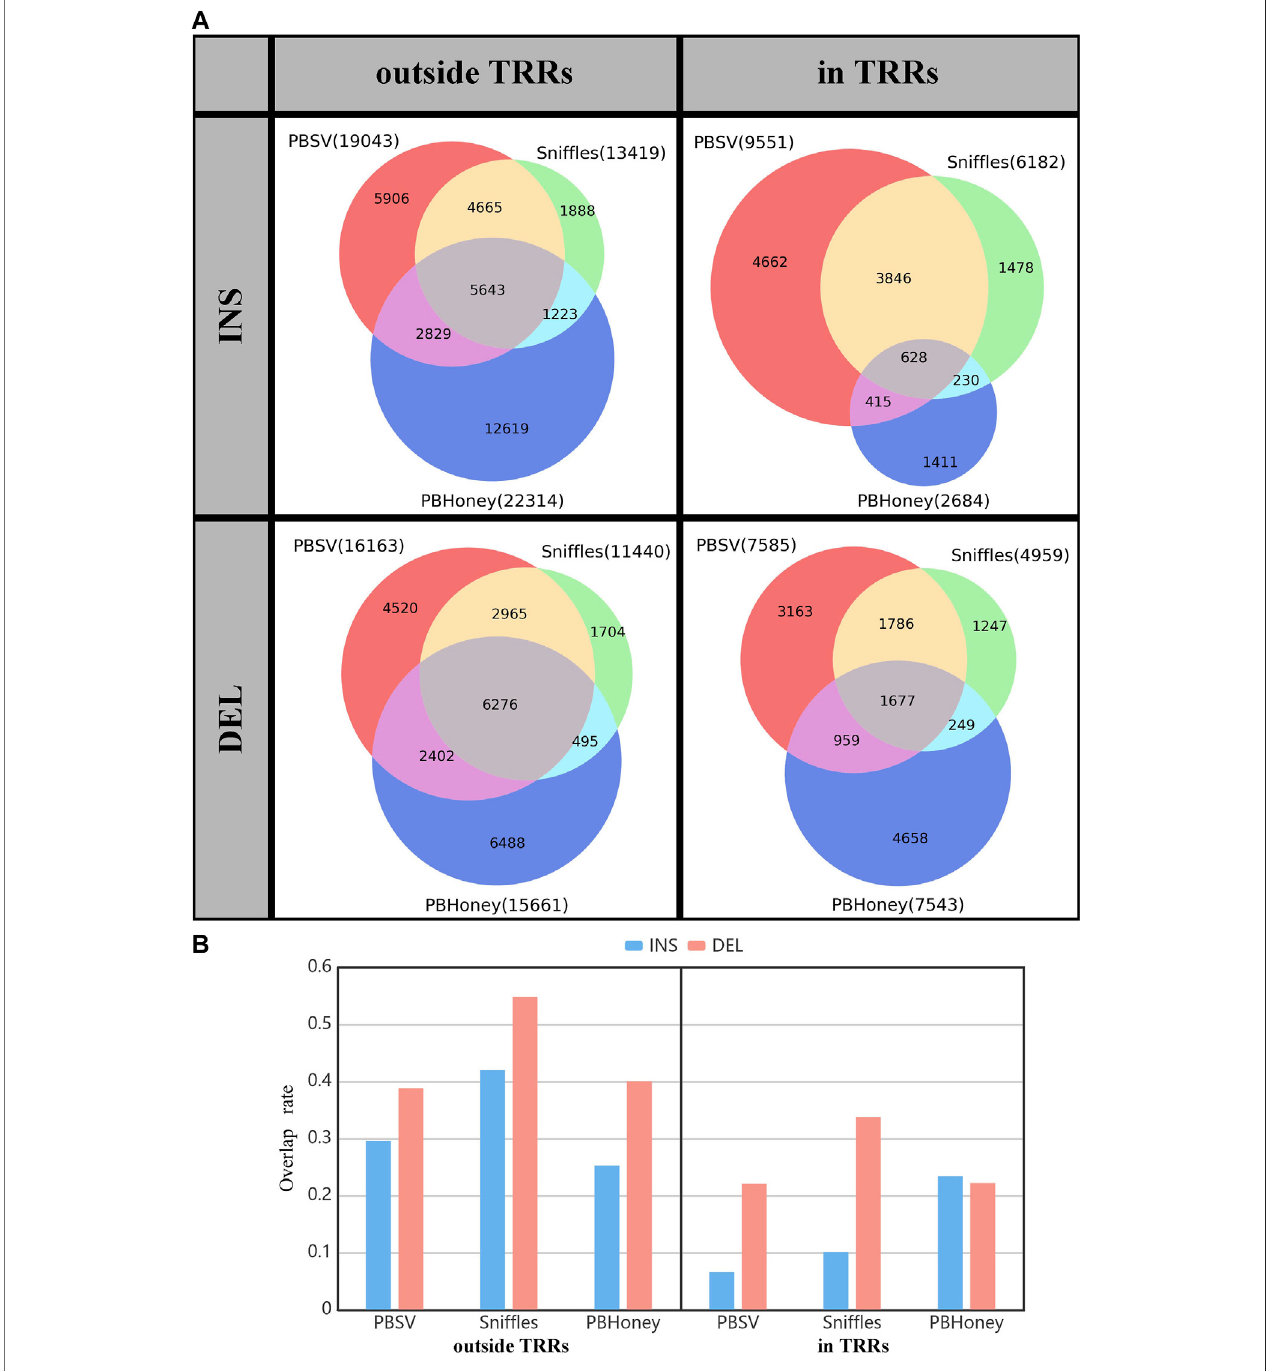
FIGURE2 |(A) Theoverlap among callsets detected by three pipelines divided by thetype and thelocationrelationwith TRRsofSVs. (B) Theoverlap rateofthree pipelines. The gray part in Figure 2A shows the overlap SVs.